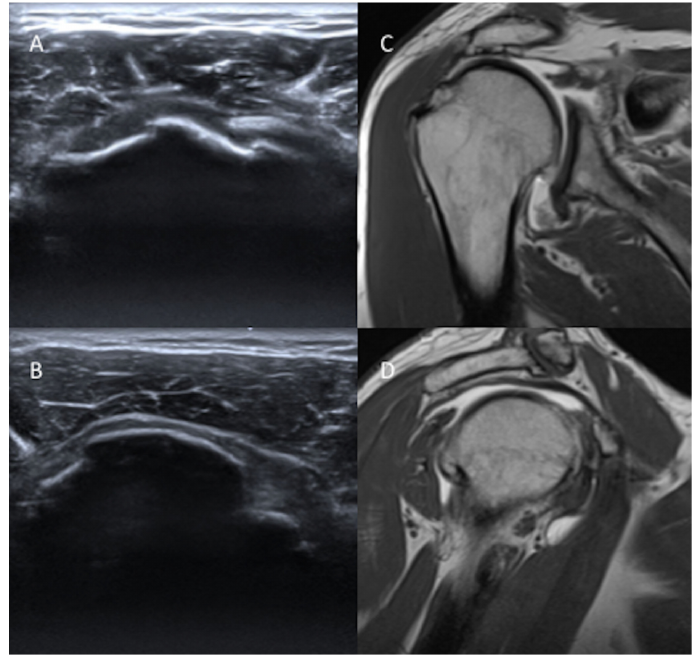
Figure 1. US images on the long axis ( A ) and short axis ( B ), coronal T1-weighted ( C ), and sagittal T1-weighted ( D ) MRA images of a 57-year-old male patient with complete supraspinatus tendon rupture.